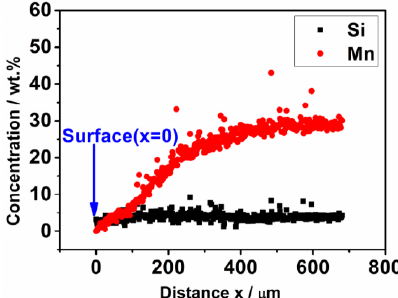
Figure 4. Mn and Si concentration of the cross-section of the MM Fe-Mn-Si alloys sintered at 1200 °C for 1 h isothermal holding.